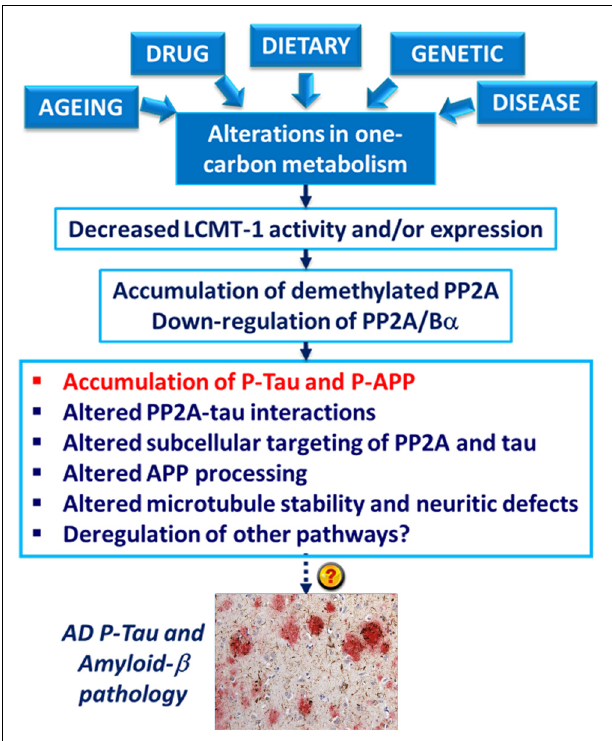
FIGURE 4 | Model for the link between alterations in one-carbon metabolism, deregulation of PP2A methylation andAD-like pathology. Dietary B-vitamin deficiency, genetic polymorphisms in key enzymes that metabolize folate and homocysteine, drugs (e.g., the anti-folate drug, methotrexate), diseases (e.g., liver disease) and aging can all lead to impairment of one-carbon metabolism. In turn, alterations in the methylation cycle result in decreased LCMT1 activity and/or expression levels, and subsequent down-regulation of PP2A methylation and PP2A/B α holoenzymes.This is associated with the accumulation of phosphorylated tau and APP proteins in vivo . Experiments in cultured cells and in vitro also link alterations in neuronal PP2A methylation with disruption of PP2A-tau protein–protein interactions, alterations in the subcellular targeting of PP2A and tau, APP processing, microtubule stability, and neuritic